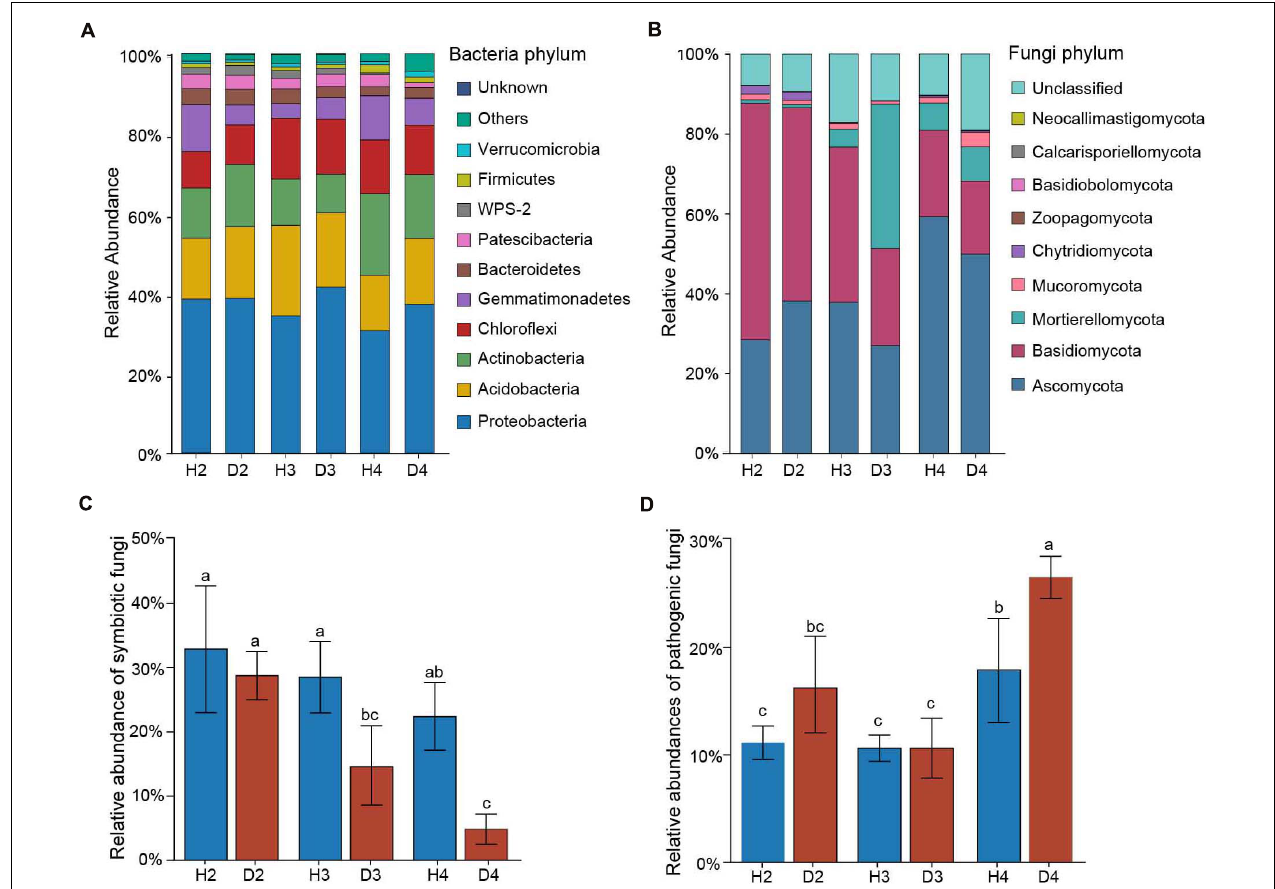
FIGURE 3 | Relative abundances of the top 10 most abundant bacteria (A) and fungi (B) at the phylum level in soil samples obtained from different aged healthy and diseased AG plants. Relative abundances of symbiotic (C) and pathogenic (D) fungi detected in the soil of different aged healthy and diseased AG plants based on FUNGuild analysis. The error bars represent standard deviations of the means. Different letters above the bars indicate significant differences among samples at P < 0.05 based on one-way ANOVA followed by Duncan’s multiple range test. H2, soils obtained from 2-year-old healthy AG plants; D2, soils obtained from 2-year-old diseased AG plants; H3, soils obtained from 3-year-old healthy AG plants; D3, soils obtained from 3-year-old diseased AG plants; H4, soils obtained from 4-year-old healthy AG plants; D4, soils obtained from 4-year-old diseased AG plants.